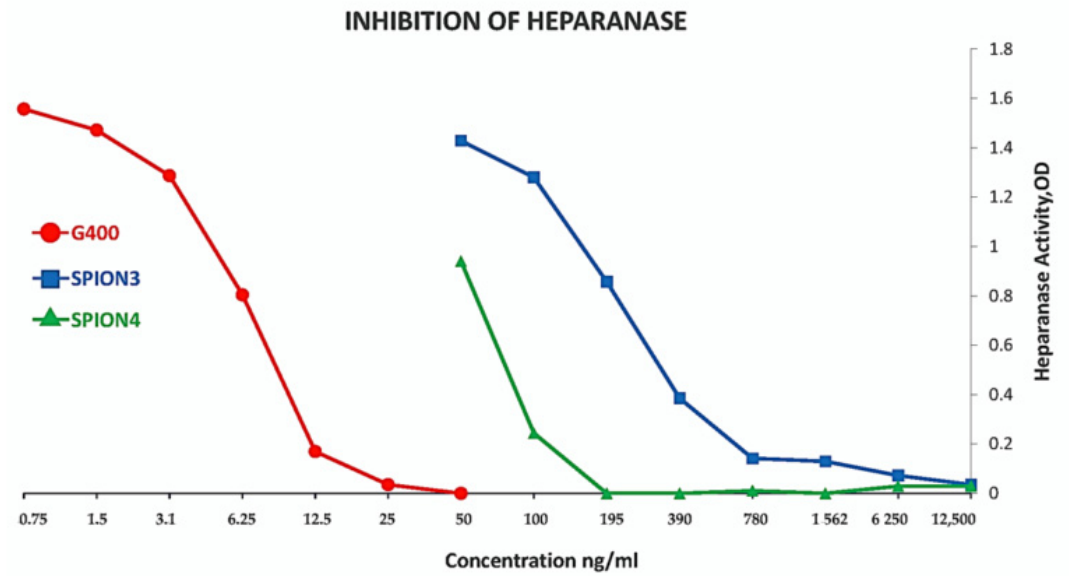
Figure 7. The LMWH@SPIONs SPION3 and SPION4 inhibit the HPSE-mediated cleavage of the synthetic HS pentasaccharide fondaparinux. Dose–response inhibition of the heparanase-mediated cleavage of fondaparinux (Arixtra) by SPION3 and SPION4 vs. G4000 (SST0001 = Roneparstat). Assay performed as described in Materials and Methods.